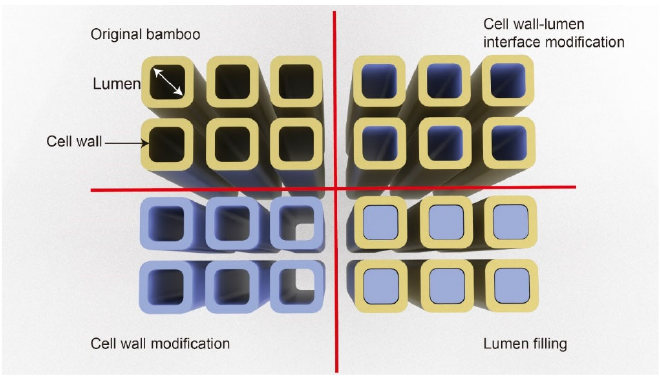
Figure 5. A selection of structural modification strategies to improve TB functionality (inspired by Burgert et al. [62]).